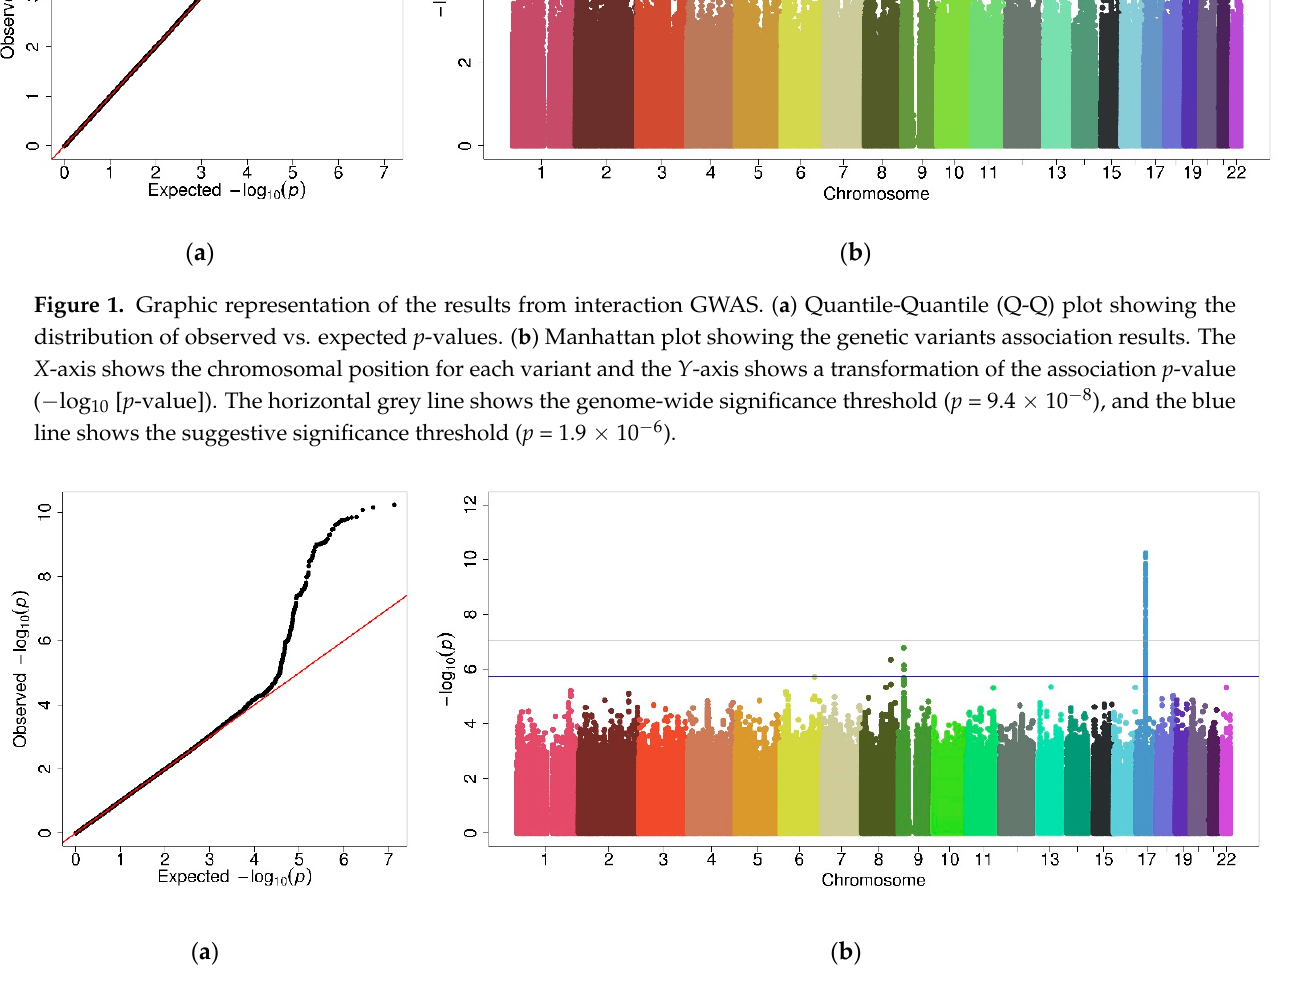
Figure 1. Graphic representation of the results from interaction GWAS. ( a ) Quantile-Quantile (Q-Q) plot showing the distribution of observed vs. expected p- values. ( b ) Manhattan plot showing the genetic variants association results. The X -axis shows the chromosomal position for each variant and the Y -axis shows a transformation of the association p -value (-log 10 [ p -value]). The horizontal grey line shows the genome-wide significance threshold ( p = 9.4 × 10 − 8 ), and the blue line shows the suggestive significance threshold ( p = 1.9 × 10 − 6 ).